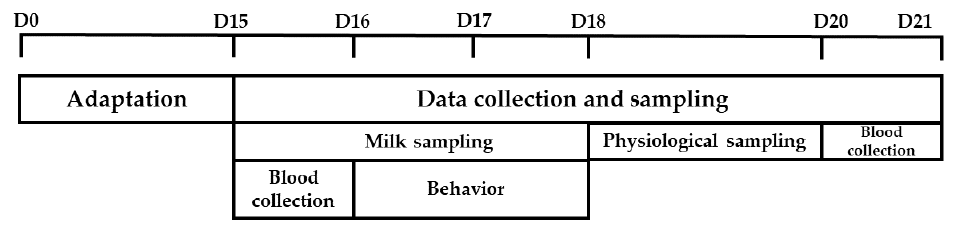
Figure 2. Schematic diagram of the experiment. Milk samples were collected every milking over 3 consecutive days (D15 to D18). Blood collection was performed on D15 and D21. Daily behavior was analyzed on D16 and D17. Physiological variables were collected from D18 to D20.